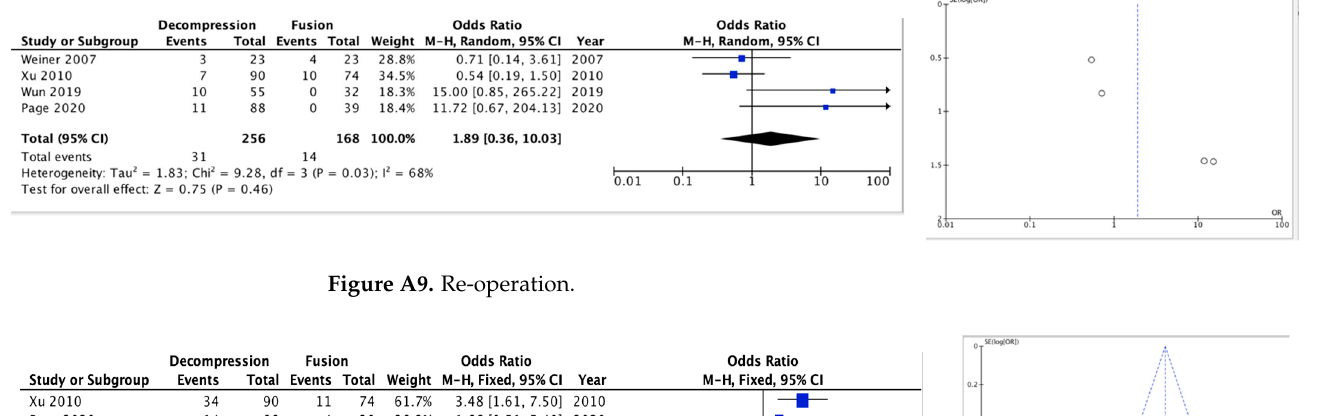
Figure A8. Cyst recurrence.